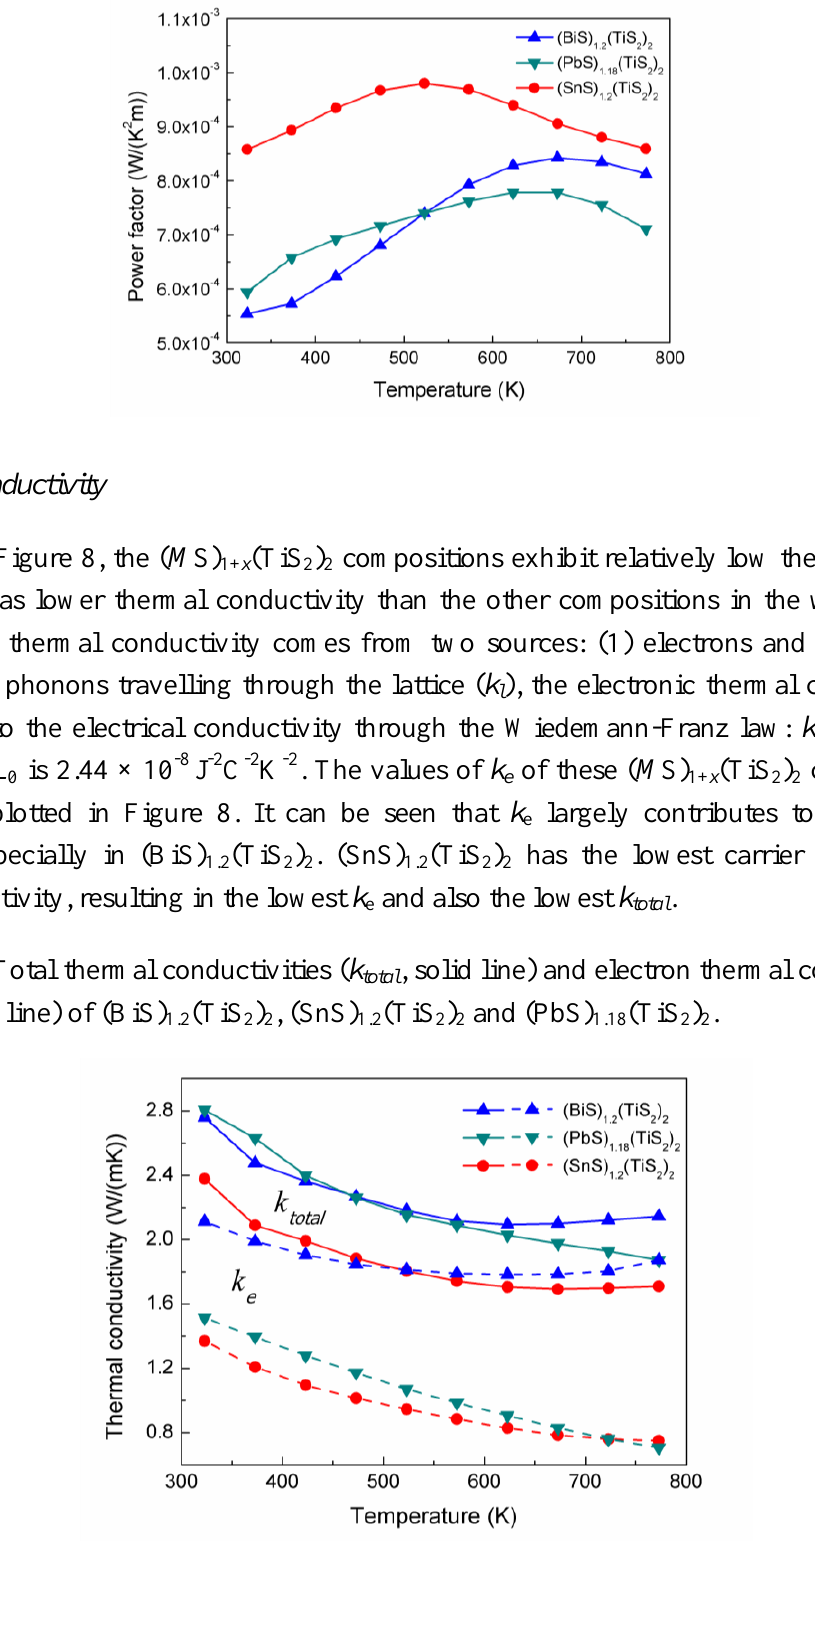
Figure 7. Power factors of (BiS) 1.2 (TiS 2 ) 2 , (SnS) 1.2 (TiS 2 ) 2 and (PbS) 1.18 (TiS 2 ) 2 .